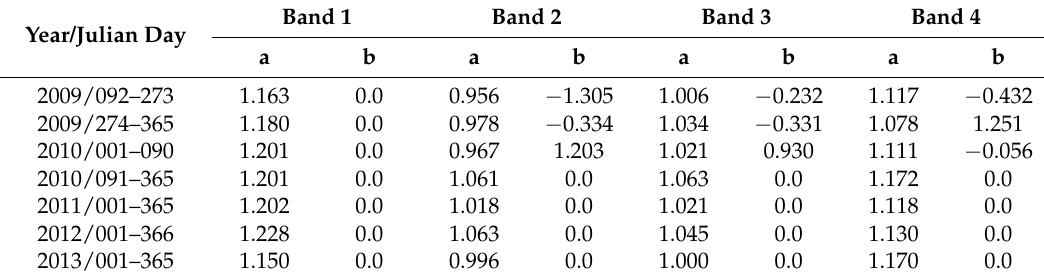
Table 3. Used radiometric degradation factors (RDFs) for TANSO-CAI and JAXA’s correction with MODIS measurements; where a and b are the values of slope and offset for the correction of each band, respectively. (2009.092–2010.090: applied JAXA correction from JAXA GOSAT project team